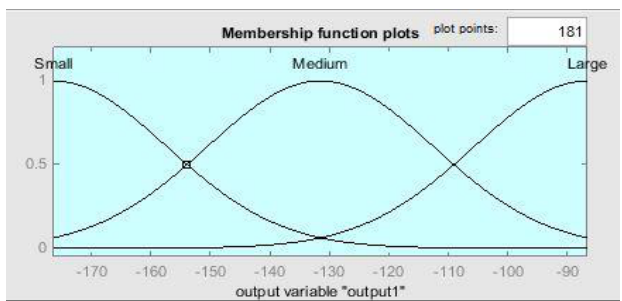
Fig. 9. Membership function for output K p variable